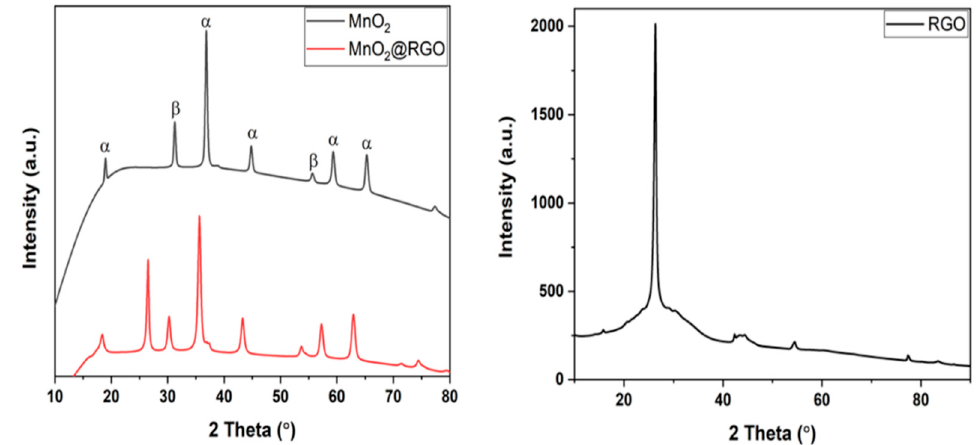
Figure 1. XRD spectra of RGO nanosheets, MnO 2 nanoparticles and MnO 2 @RGO nanocomposite.